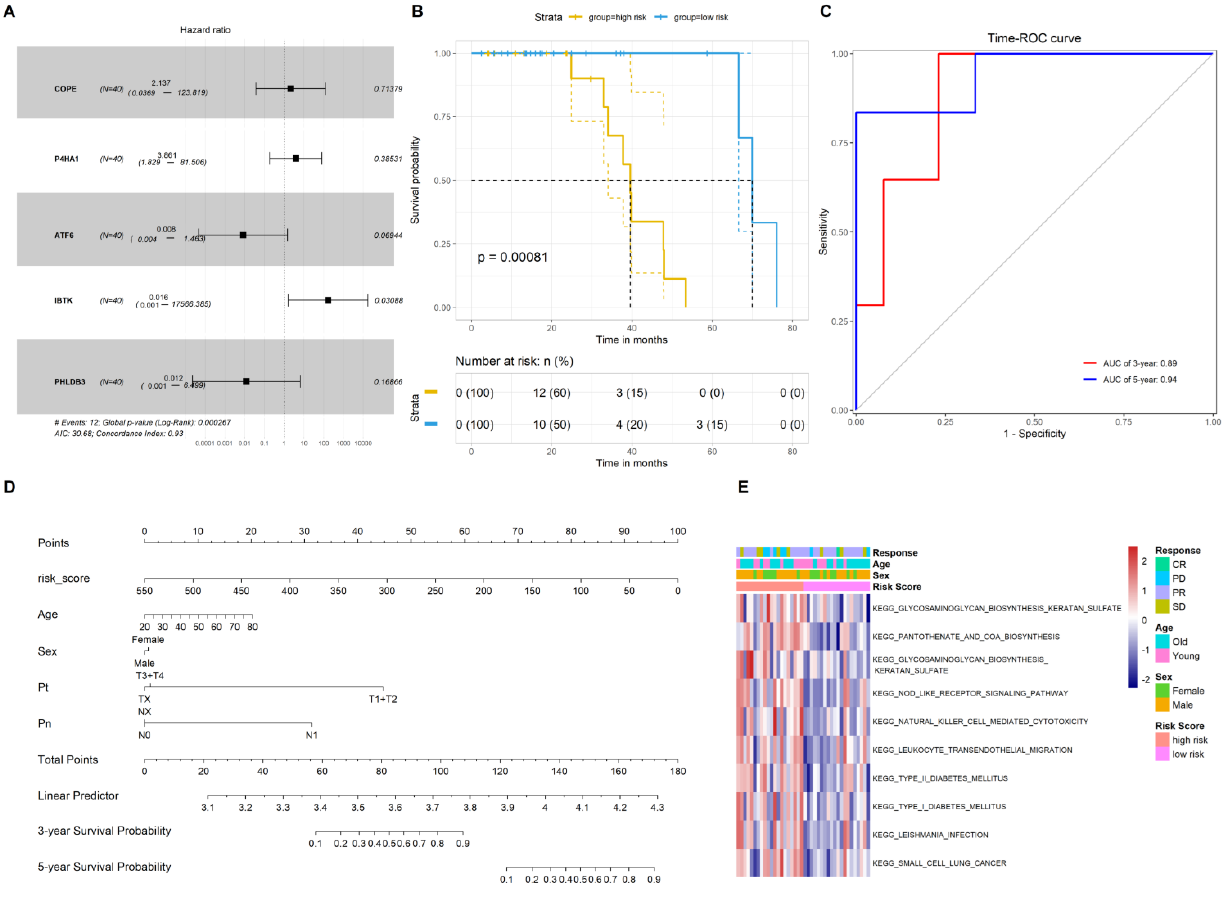
Figure 2. Identification of gene signatures associated with the prognosis of patients who underwent chemotherapy. ( A ) Five oxaliplatin resistance related genes were identified with the prognosis of CRC patients; ( B ) Kaplan–Meier plot revealed the survival time between high- and low-risk scores of gene signatures; ( C ) prognostic values of gene signatures for the 1-, 3-, and 5-year survival of patients; ( D ) nomogram plot of the gene signatures and other clinical features with the prognostic values of patients; ( E ) GSVA algorithm revealed the pathways that gene signatures were involved in.